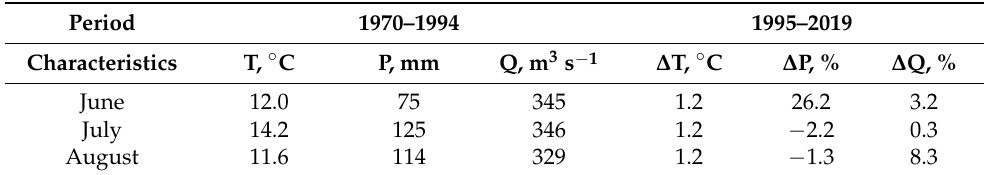
Table 7. Changes in hydrometeorological characteristics (T—air temperature, P—precipitation,